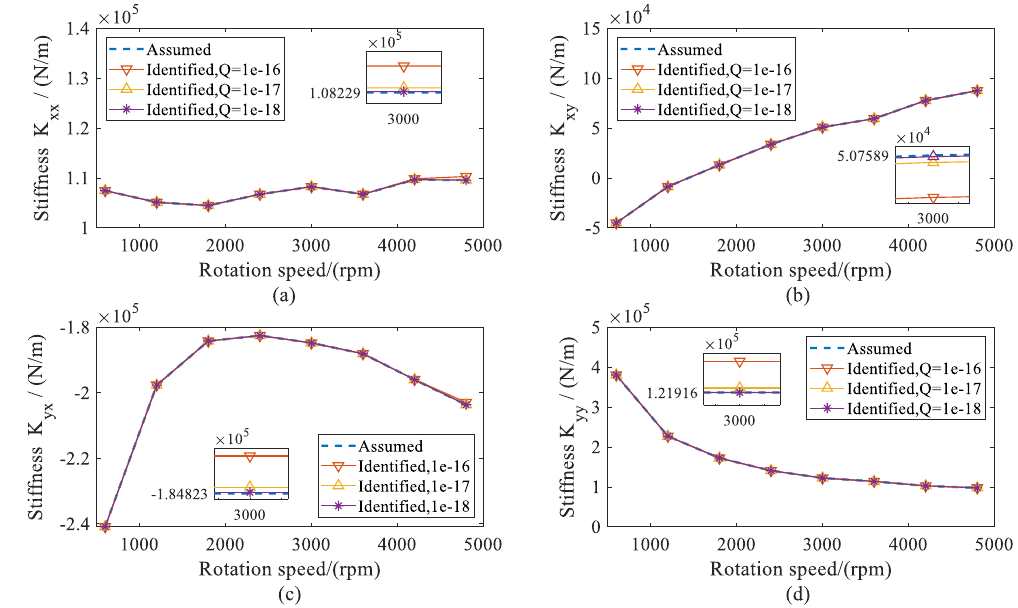
Figure 7. Assumed and identified stiffness coefficients of bearing 2 versus rotation speed; ( a ) direct stiffness coefficient K xx ; ( b ) cross-coupled stiffness coefficient K xy ; ( c ) cross-coupled stiffness coefficients K yx ; ( d ) direct stiffness coefficients K yy .